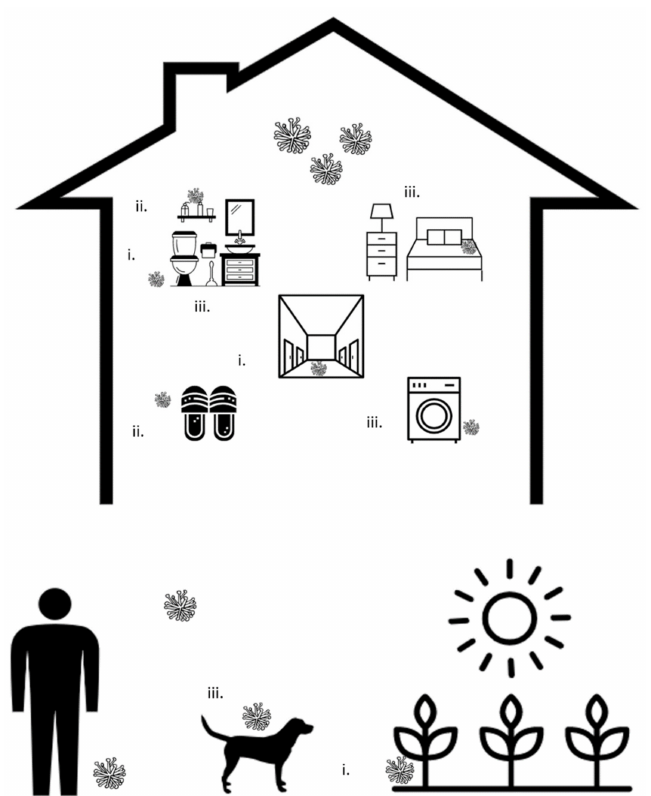
Figure 1. Summary of potential pathways involved in the household transmission of onychomycosis: ( i ) Shared surfaces within the household may harbor fungi and provide sources for transmission.